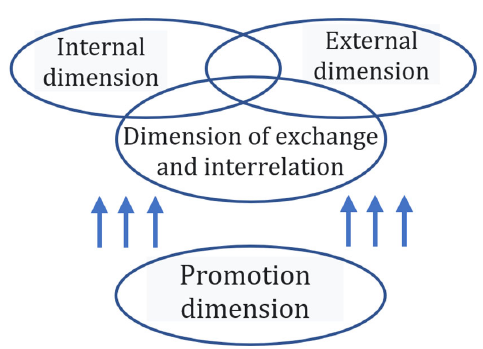
Fig. 1, Dimensions of digital government according to Armas & Armas